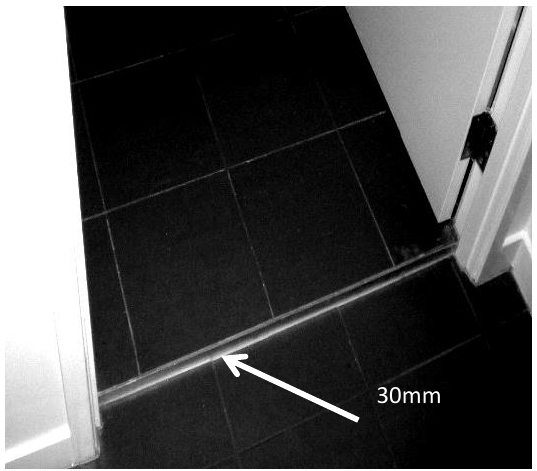
Figure 2 . Step into the bathroom.